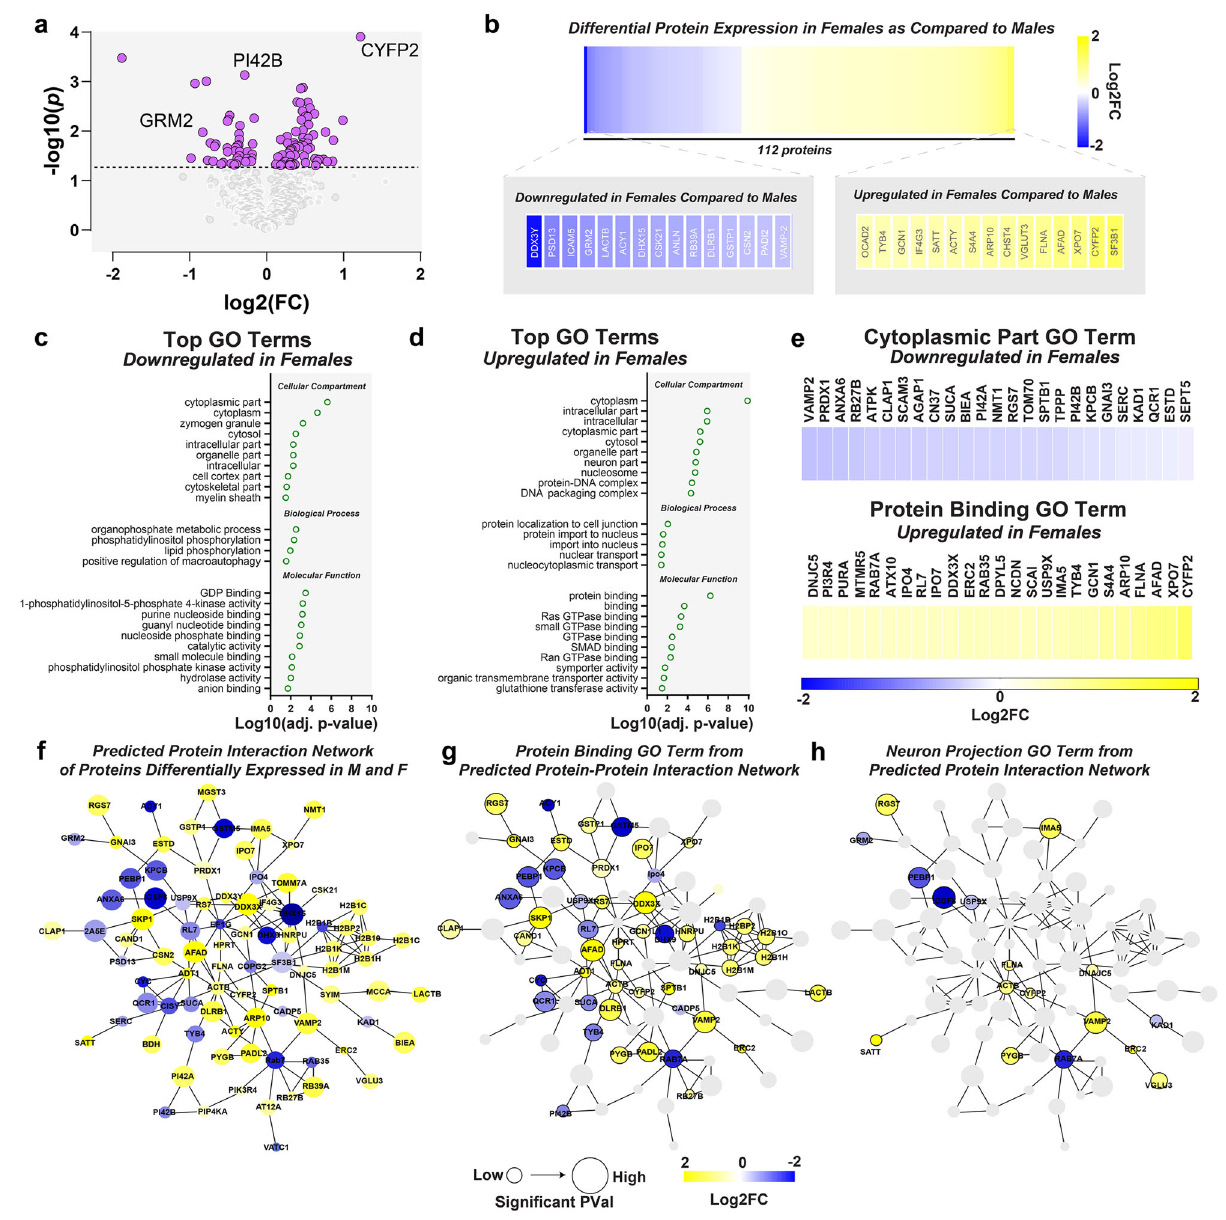
Fig. 2 Sexual dimorphisms in the proteomic landscape of the nucleus accumbens. Mass spectrometry was run on tissue from the nucleus accumbens (NAc) of male and female mice to determine the proteomic landscape. Differential expression between females as compared to males was assessed in control mice. a Volcano plot showing sexually dimorphic proteins in the nucleus accumbens from female versus male mice. Male and female accumbens proteomes diverge at key proteins — some associated with reward and drug response are noted. b Heat map of baseline sexually dimorphic proteins in the accumbens. Insets showing the top 15 proteins that were decreased (left) and increased (right) in females as compared to males. c In order to conduct Gene Ontology (GO) analysis protein names had to be converted to associated gene names. These conversions are available in Supplementary Data 1. Top GO terms in proteins downregulated in females (compared to males) and d proteins upregulated in females (compared to males). e Proteins making up the representative GO terms (top) downregulated in females (cytoplasmic part) and (bottom) upregulated in females (protein binding). f STRING analysis of predicted protein interaction network of proteins differentially expressed in males and females ( g ) within the protein binding cluster, and ( h ) neuron across a variety of paradigms (Fig. 3a and Supplementary Fig. 3a). Male and female mice acquired cocaine self-administration (at 1 mg/ kg/injection i.v.) at equal rates and consume similar levels of cocaine on low effort schedules (FR1), as well as higher effort fi xed ratio schedules (FR3 and FR5; Fig. 3b; two-way repeated measures ANOVA: female: signi fi cant effect of lever [ F (1, 36) = 92.60, p < 0.0001; signi fi cant effect of schedule [ F (2.565, 91.39) = 22.02, p < 0.0001]; signi fi cant interaction [ F (8, 285) = 20.49, p < 0.0001]; male: signi fi cant effect of lever [ F (1, 32) = 92.39, p < 0.0001]; signi fi cant